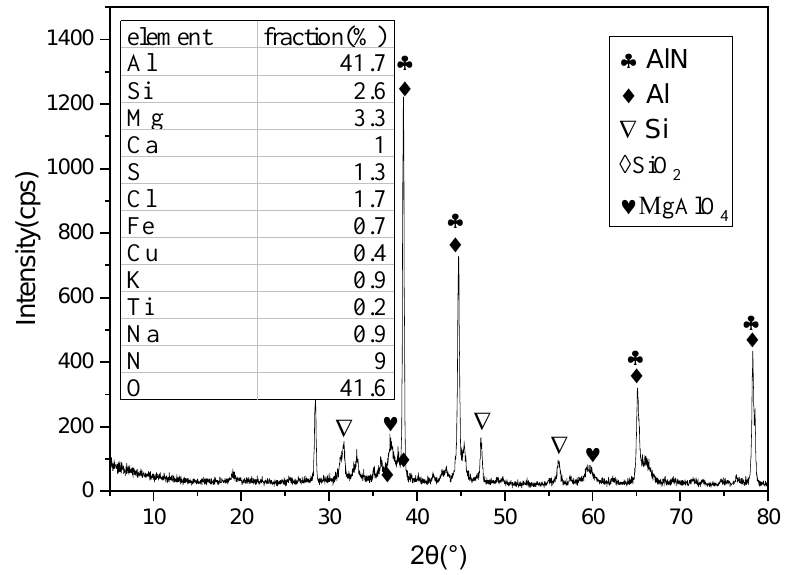
Figure 1. XRD pattern of AD with the element content (inner table).